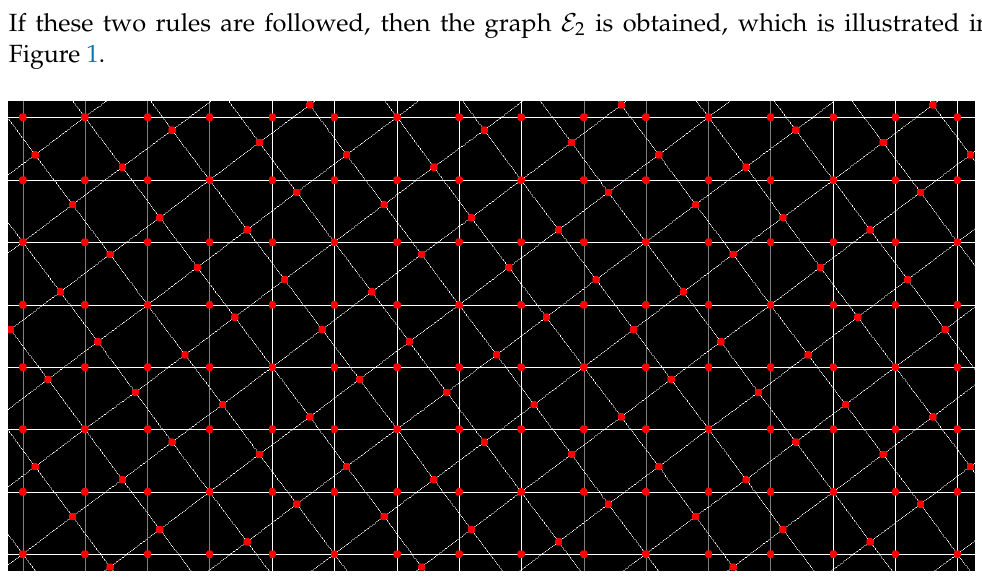
Figure 1. Graph E 2 that was formed from two interlacing square lattice graphs by simple local rules. Shared vertices can be seen to have eight